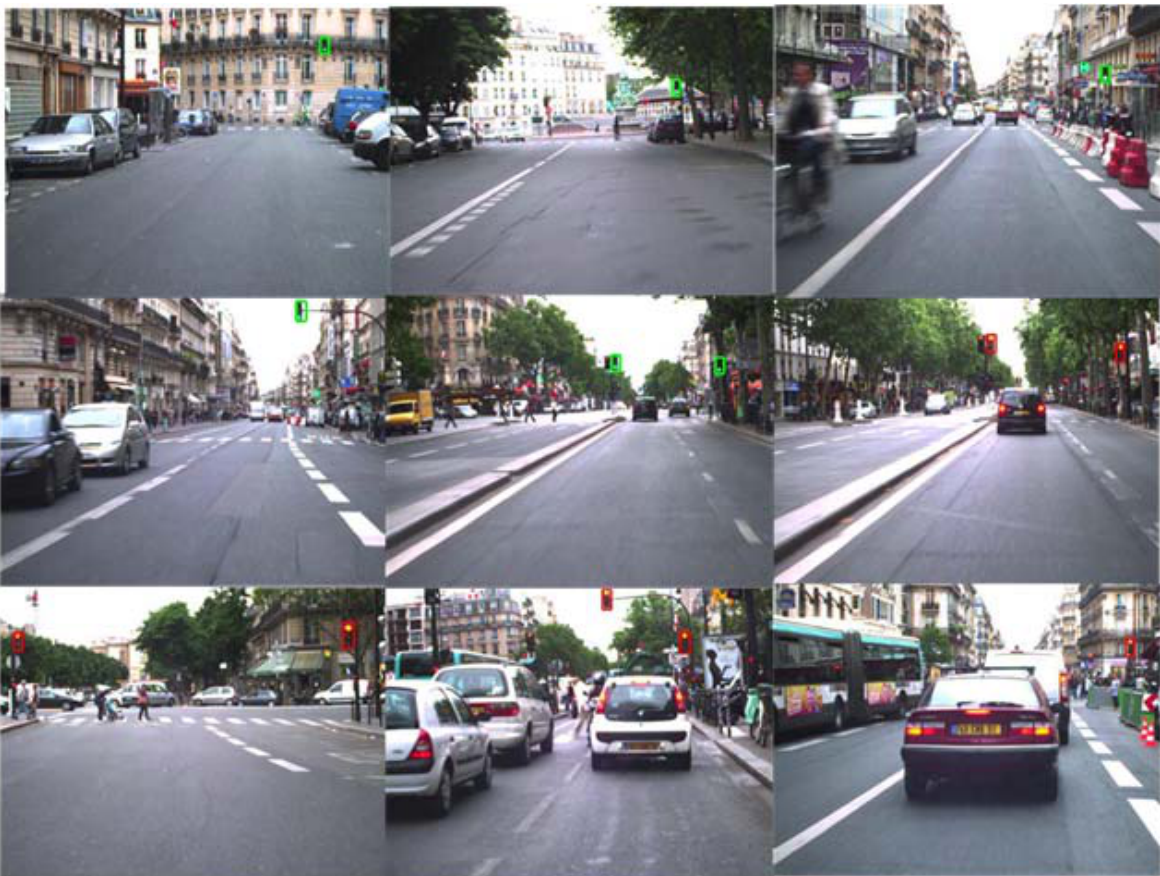
Fig. 7. Result of The traffic lights recognition